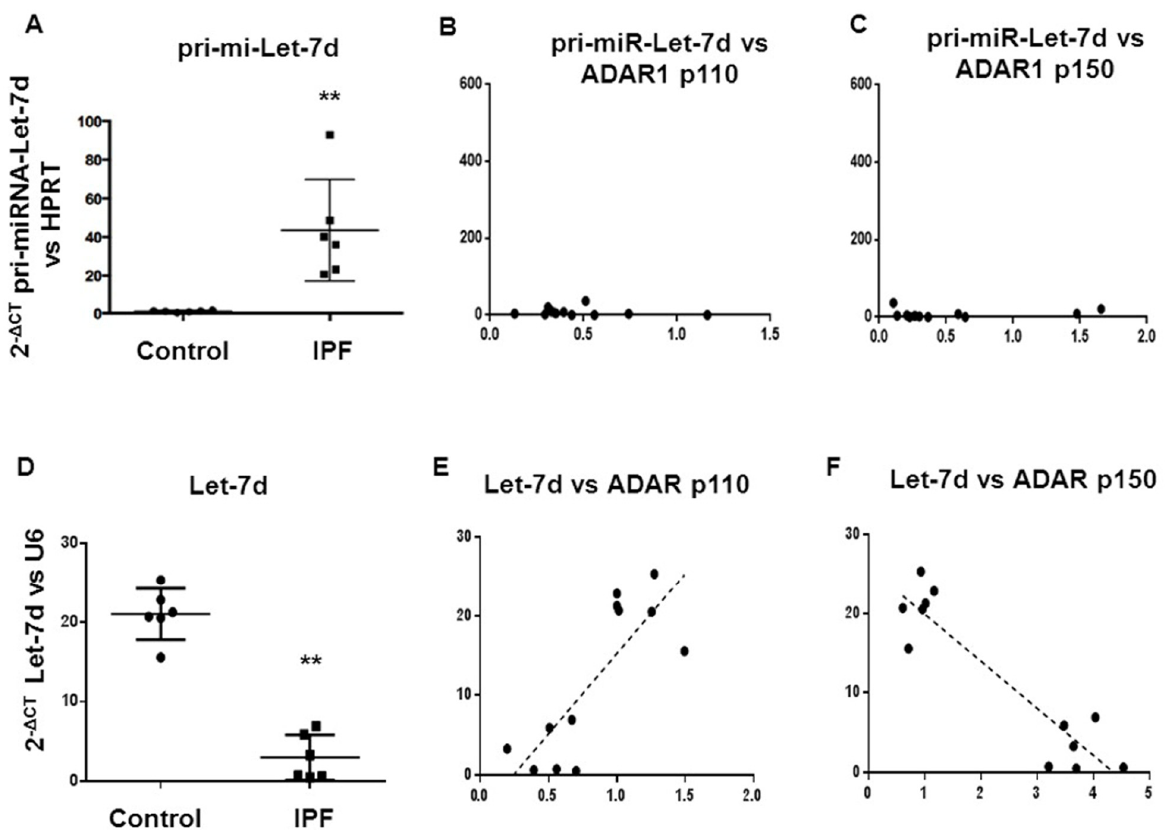
Figure 5. pri-miRNA-Let-7d is over-expressed in IPF fibroblasts, and Let-7d is downregulated in IPF fibroblasts and fibrotic mice lugs. The expression of pri-miRNA- Let-7d is higher in IPF fibroblasts than in control fibroblasts (* p = 0.05) ( A ). The correlation of ADAR1 isoforms does not show significant differences between ADAR1-p110 ( B ) and ADAR1-p150 ( C ). The expression of Let-7d is lower in IPF fibroblasts compared to the expression levels of control fibroblasts (** p = 0.0028) ( D ). Let-7d displayed a negative correlation with ADAR1-p150 ( p < 0.0001) ( E ) and a positive correlation with ADAR1-p110 ( p = 0.0014) ( F ).